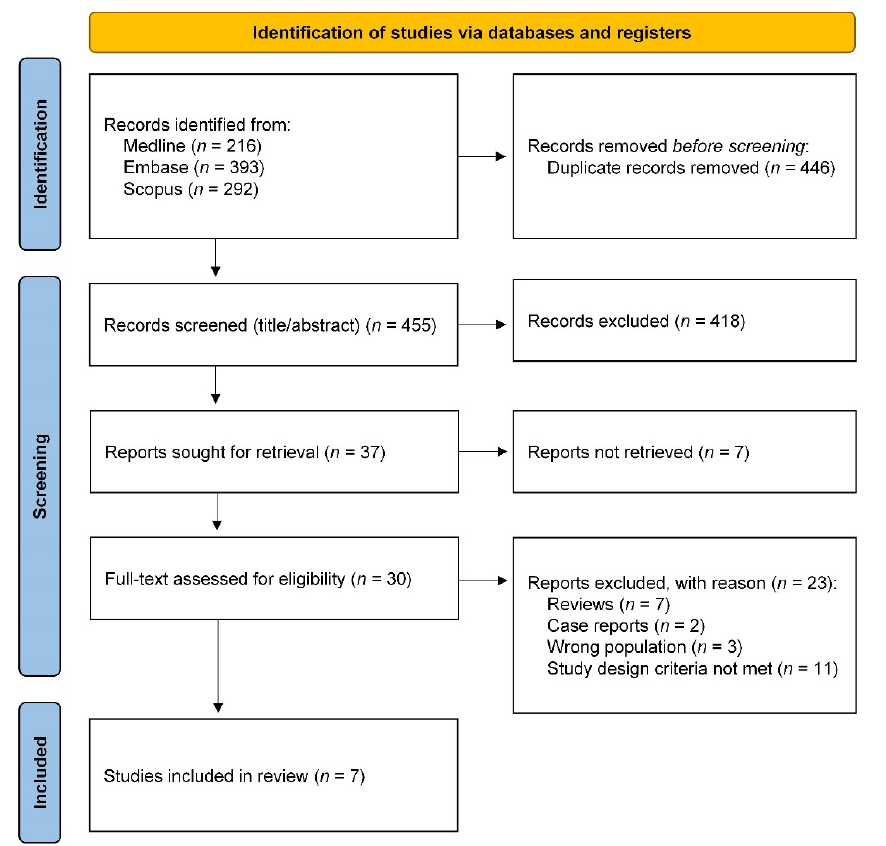
Figure 1. Preferred Reporting Items for Systematic Reviews and Meta-Analyses (PRISMA) flow diagram for selection of studies [15]. Table 1. Characteristics of included